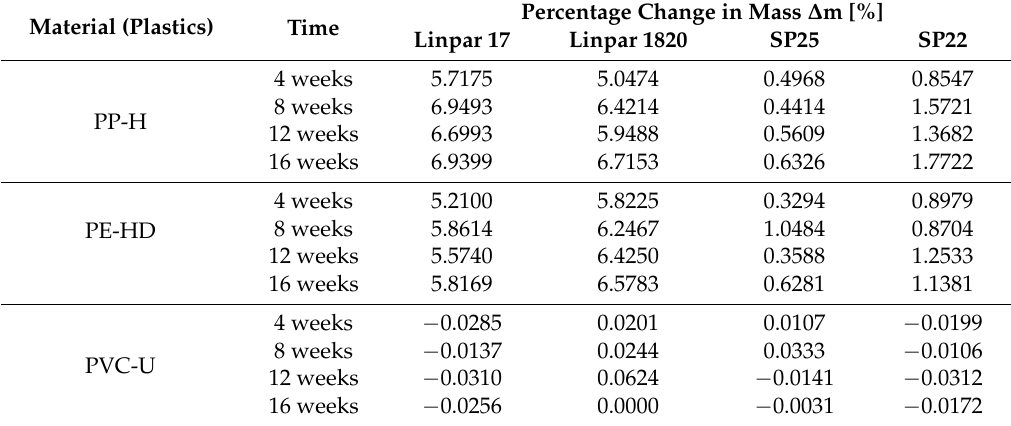
Table 1. Percentage change in mass of tested plastics depending on used PCMs through